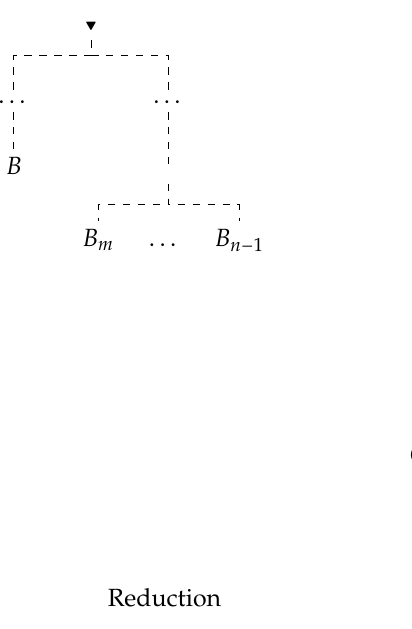
Figure 16. Theorem 5: